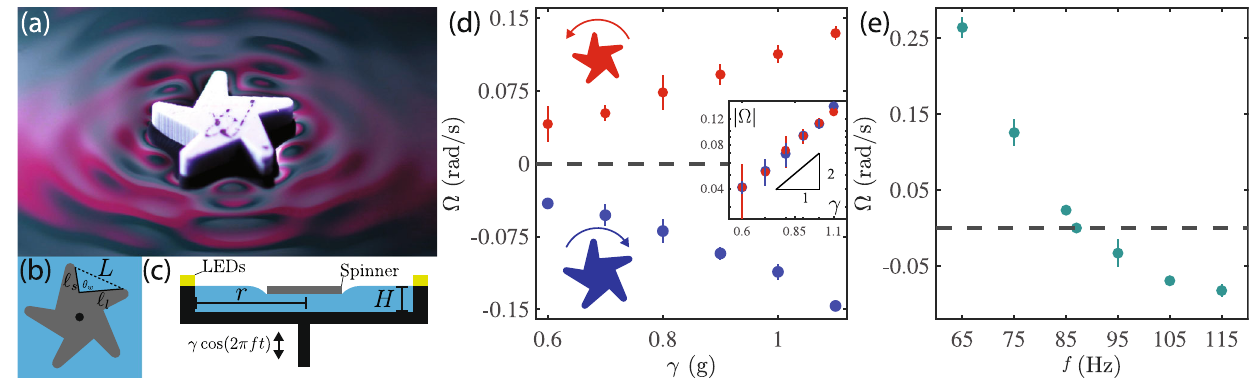
Fig. 1 Illustration of the experimental setup and angular velocity data. a Oblique perspective of a chiral spinner on the surface of a vibrating fl uid bath. The self-generated capillary wave fi eld of the spinner is visualized by the distortions of a re fl ected color pattern 69 . b A schematic of the spinner geometry: each wedge consists of a long arm of length ℓ l and short arm of length ℓ s , separated by an angle θ w = 94.4 π /180. All spinners are geometrically similar and are characterized by the opening length L . c A schematic of the experimental set-up: a chiral spinner rests on the surface of an illuminated circular liquid bath of height H = 5.7 mm and radius r = 50 mm. The bath is oscillated vertically at a frequency f with maximum acceleration amplitude γ . d Angular velocity of a large ( L = 6.3 mm, blue) spinner and small ( L = 4.6 mm, red) spinner as function of γ at fi xed frequency f = 95 Hz for γ / g = (0.6, 0.7, … , 1.1). Inset: a square dependence of the angular speed on the driving acceleration for both sizes of spinner is consistent with the physics of wave-radiation stress. e For a fi xed value of γ = 1g, the angular velocity of a spinner ( L = 5.5 mm) decreases monotonically as function of f from f = 65 Hz to the fl ipping frequency f * ≈ 87 Hz. Thereafter, the angular velocity switches sign. The error bars in d and e represent one standard deviation in the angular velocity over at least four trials, and in some cases are smaller than the marker size